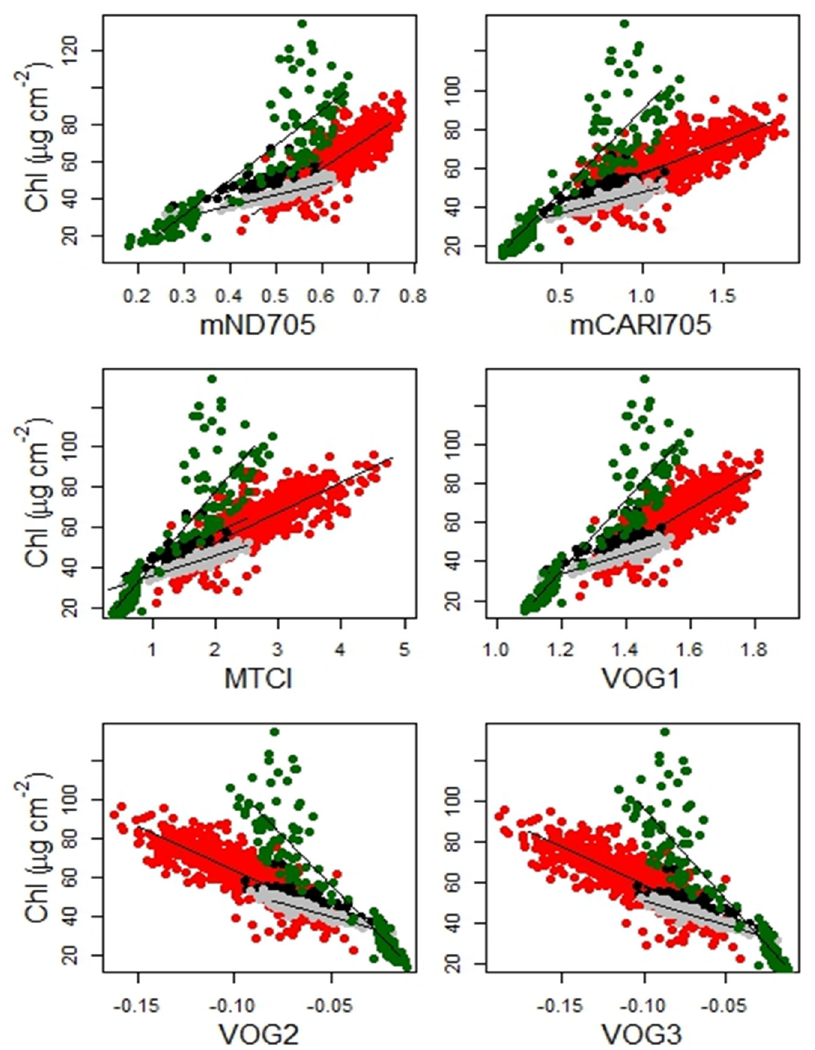
Figure 5. Scatterplots of VIs that showed the highest correlation ( R 2 > 0.53) with CC. Red: R. mangle , black: A. germinans , grey: L. racemosa , and green: C. erectus